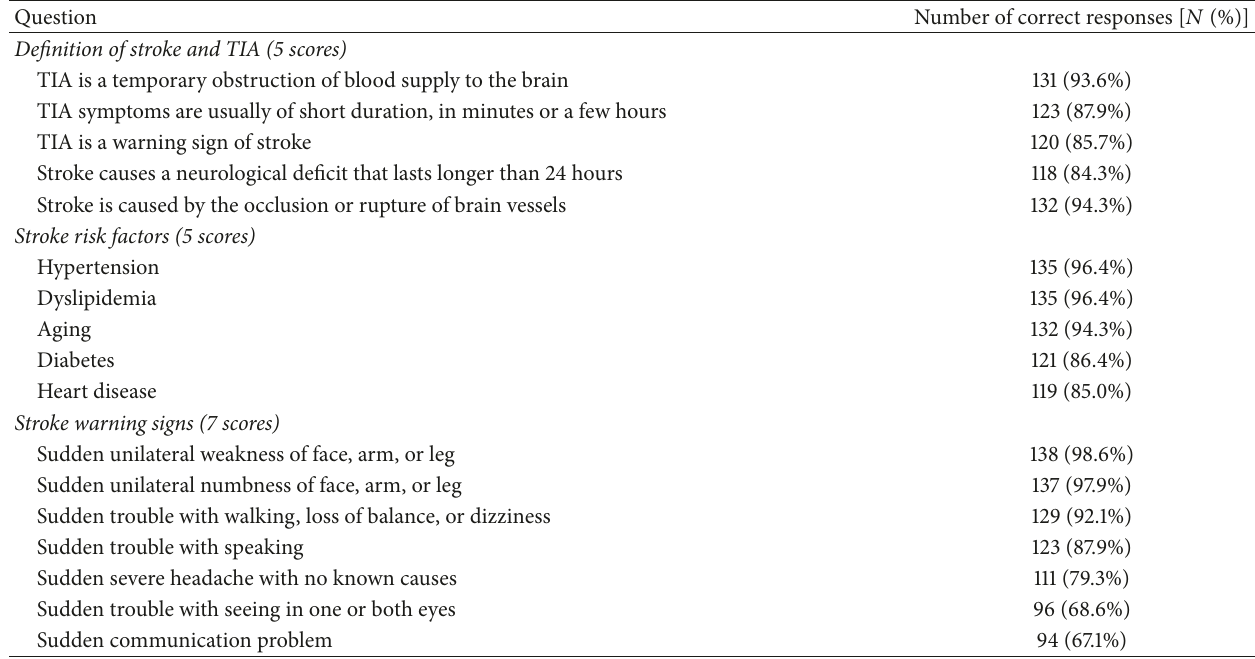
Table 4: Knowledge of stroke risk factors and warning signs in patients (closed-ended questionnaire).